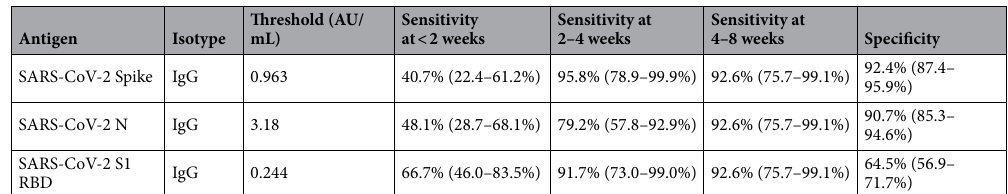
Table 3. Sensitivity and specificity of salivary IgG for detection of prior SARS-CoV-2 infection. Point estimates and 95% confidence intervals (indicated in parentheses) were computed at pre-established